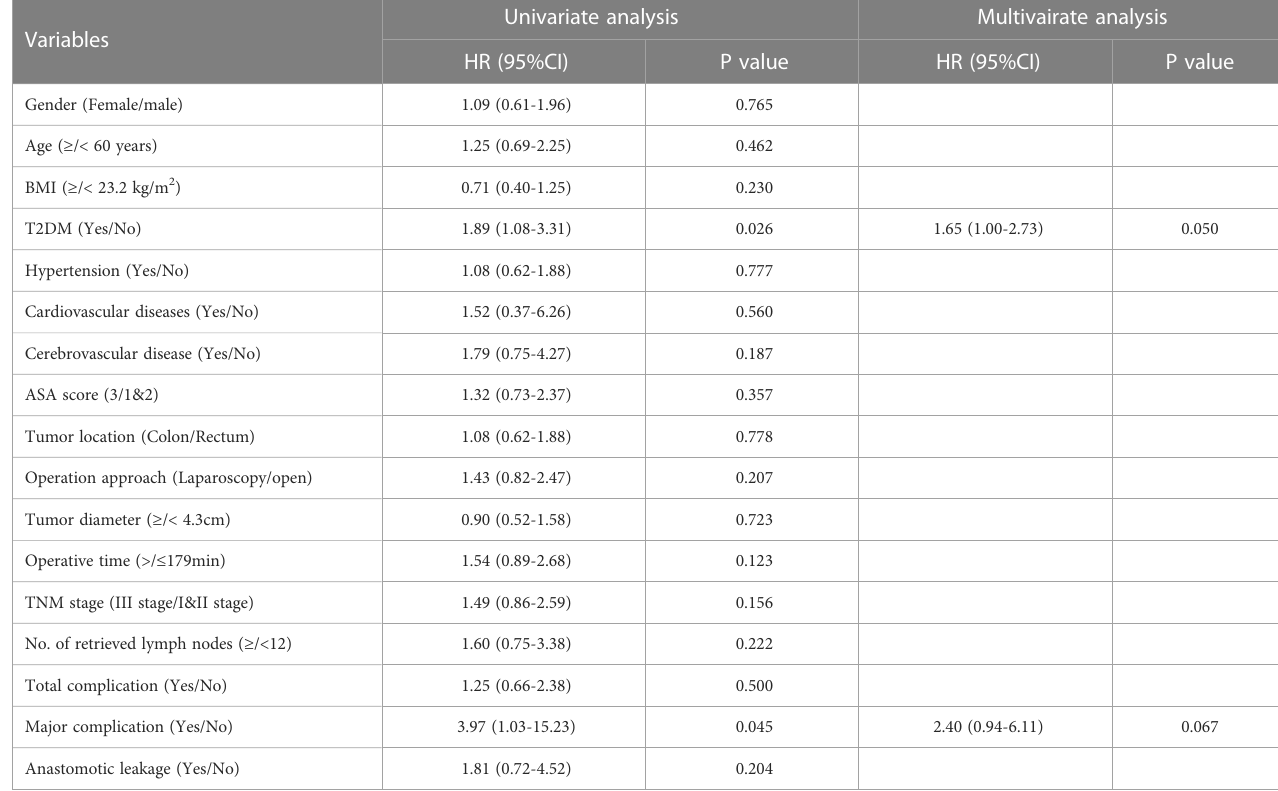
TABLE 5 Univariate and multivariate COX regression analyses of 5-year disease-free survival.